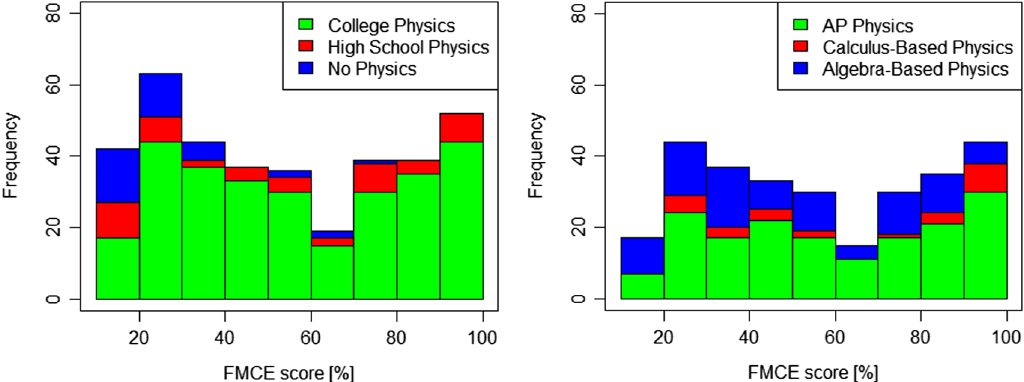
FIG. 1. Left: Histogram of FMCE prescores for students with no prior physics background (blue, N ¼ 45 ), high school physics (red, N ¼ 57 ), and AP or college physics (green, N ¼ 328 ). Right: Histogram of FMCE prescores for students with college-level